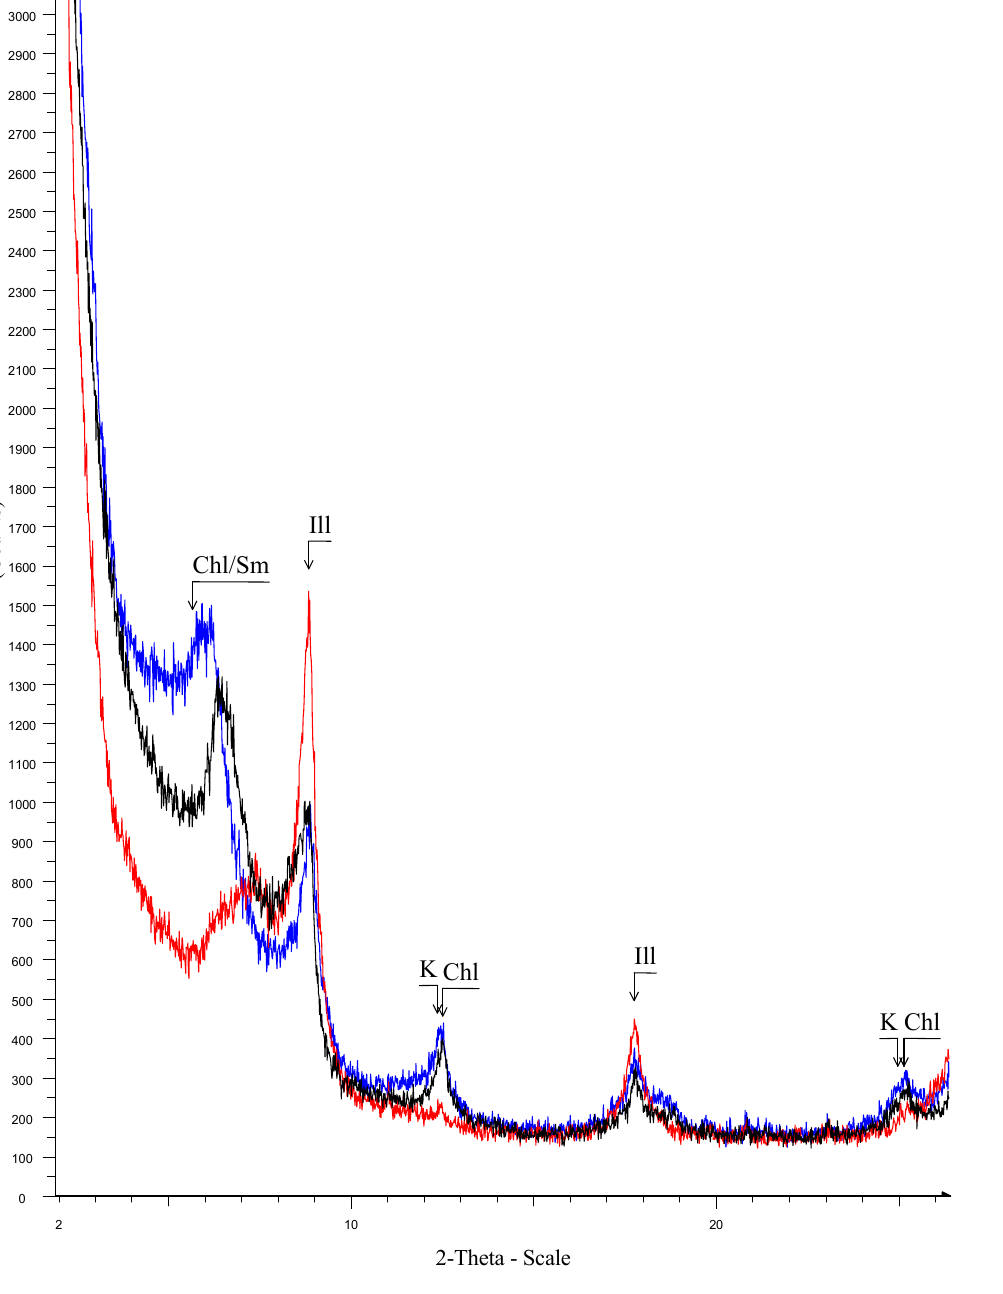
Figure A3. Representative composite diffractogram of the illitic clayey raw materials established according to the clay minerals content revealed from the <2 μ m fraction. The diffraction pattern of each preparation is intentionally equally displaced in respect to Y axis to obtain a better visual. Abbreviations: Ill = Illite, Chl = Chlorite, K = Kaolinite, Chl/Sm = Chlorite/Smectite. Red line = heated at 490 °C; Blue line = ethylene-glycol solvation; Black line = air dried.